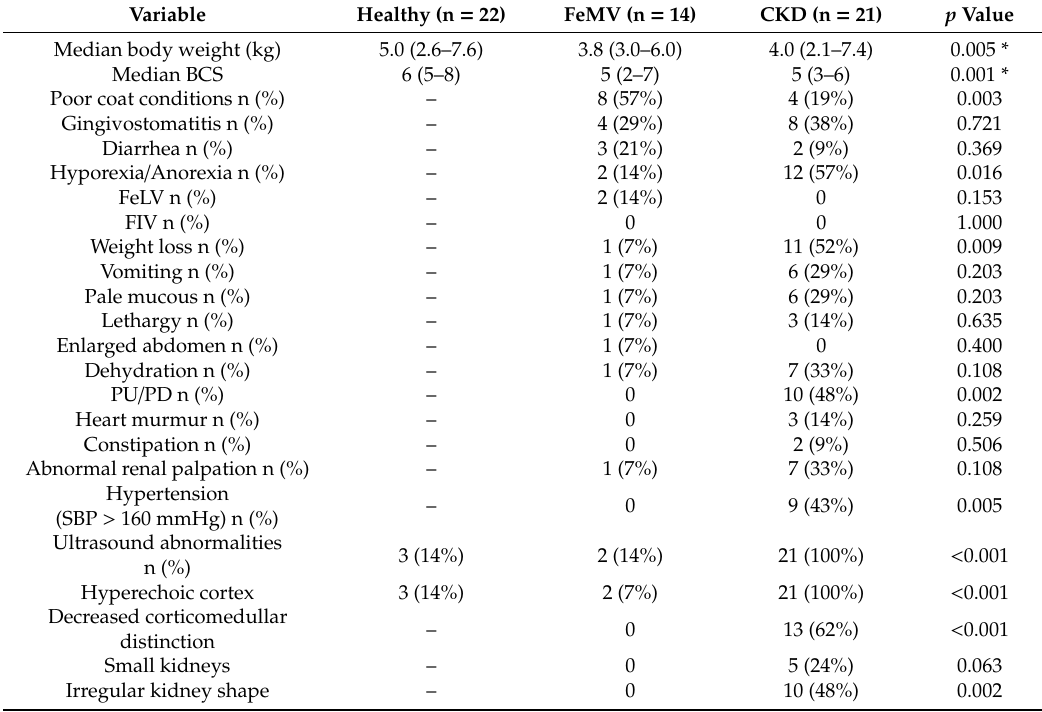
Table 1. Main complaints, physical examination and ultrasound findings and retroviral status of healthy cats (n = 22) and cats belonging to the FeMV (n = 14) and the CKD (n = 21) groups.